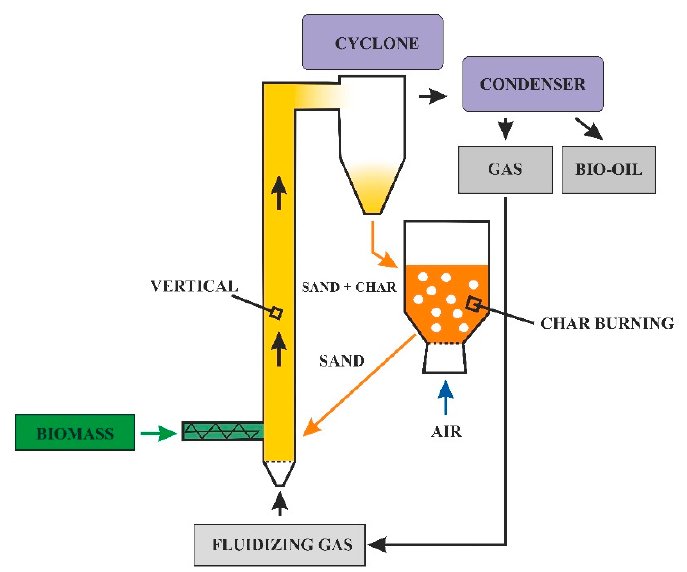
Figure 3. Moving circulating fluidized bed reactor.